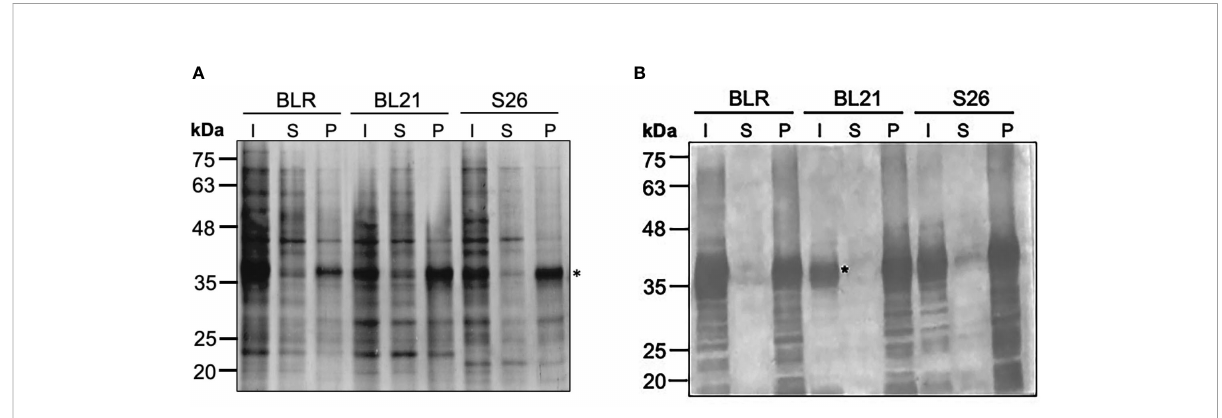
FIGURE 1 Optimization of the Expression of Tag-free CyRPA. (A) Different E. coli strains- BLR (DE3), BL21 (DE3) and Shuf fl e 26 (DE3) were tested for the expression of tag-free CyRPA. CyRPA expression was analyzed in the induced samples both in the supernatant and pellet fraction by Coomassie stained reducing SDS-PAGE. CyRPA was observed in all the three strains with BL21 (DE3) inducing the highest expression. (B) The expression of tag-free CyRPA as shown in (A) was con fi rmed by immunoblotting using anti-CyRPA rabbit polyclonal sera. Consistent with SDS-PAGE results, anti-CyRPA sera con fi rmed tag-free CyRPA expression in all the three E. coli strains. * indicating the position of CyRPA. I, Induced; S, Supernatant; P, Pellet; S26, Shuf fl e